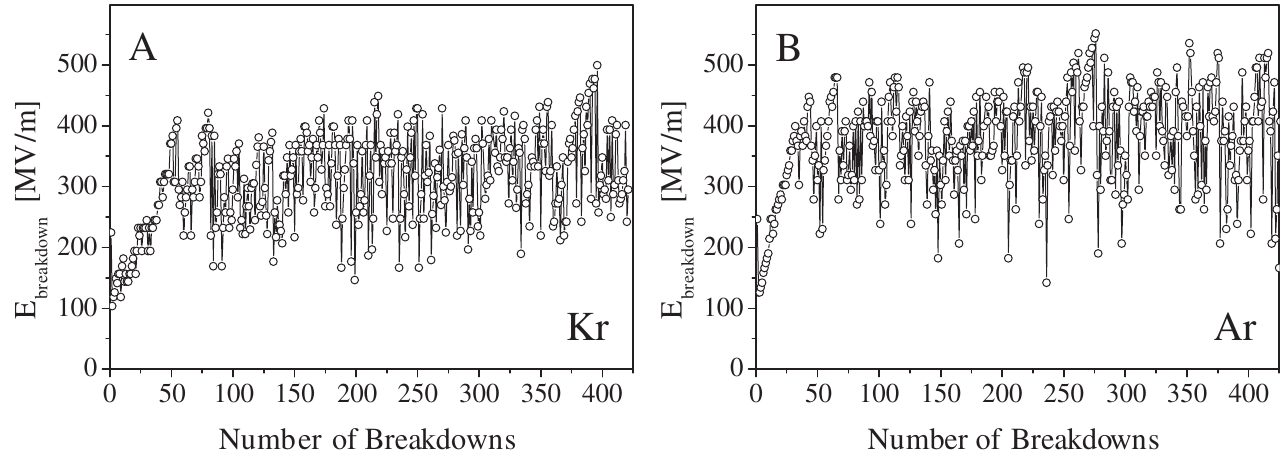
FIG. 3. Breakdown fields for molybdenum after ex situ sputter cleaning with (A) 0.3 keV Kr (cid:3) ions and (B) 3 keV Ar (cid:3) ions. The E are determined to be (cid:9) 337 (cid:8) 6 (cid:10) MV = m and (cid:9) 395 (cid:8) 5 (cid:10) MV = m for Kr (cid:3) - and Ar (cid:3) -ion treated molybdenum, respectively. During the conditioning the ambient pressure remained less than 10 (cid:2) 9 mbar